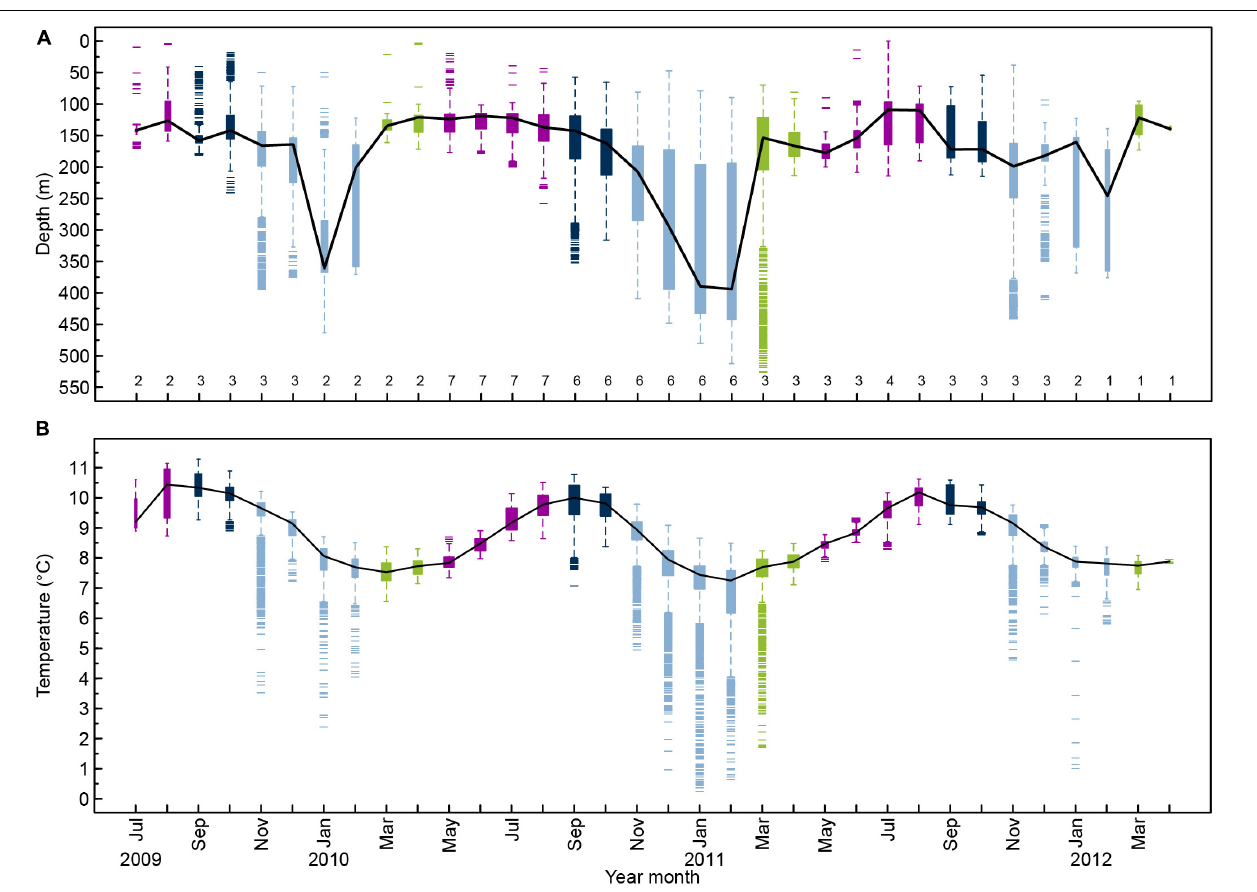
FIGURE 9 | Distributions of (A) depth and (B) ambient temperature per month for the period July 2009 to April 2012 from pooled DST data of 10 anglerfish larger than 70 cm. The numbers inside the x -axis is number of anglerfish. The black line is the median, the box represents the upper and lower quartile, the error bars are upper and lower extremes (excluding outliers) and the short lines are outliers. The outliers are defined as values 1.5 times larger than the inter-quartile range. The width of the box indicates the sample size (a broader box indicates larger sample size). The colors indicate different